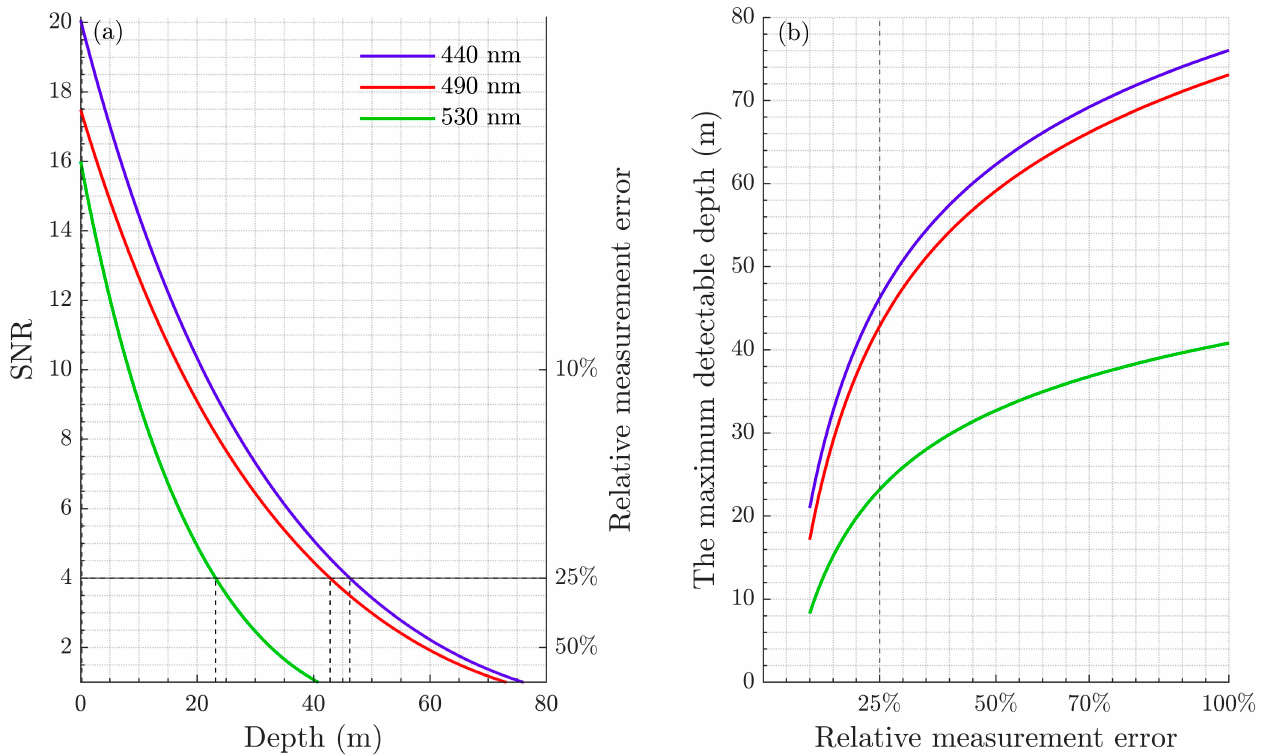
Figure 4. Simulated SNR ( a ) and maximum detectable depths versus several different relative measurement errors ( b ) in the case of water condition with chlorophyll concentration of 0.1 mg/m 3 and laser wavelengths of 440 nm, 490 nm, and 530 nm.